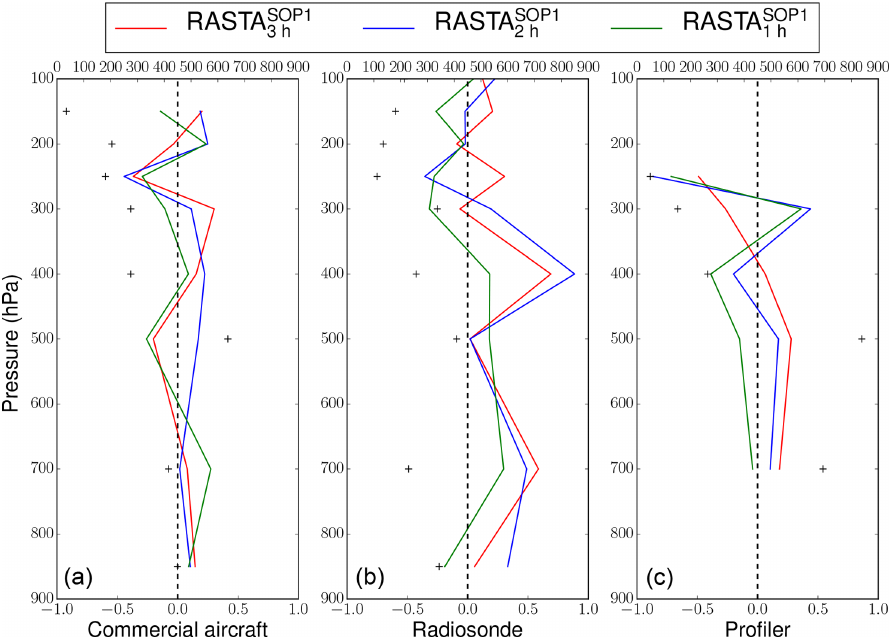
Figure 9. Differences of standard deviation error for 3h wind forecasts between the CTRL COP1 experiment and the RASTA SOP1 RASTA SOP1 (blue) and the RASTA SOP1 (green) experiments. Negative differences indicate a positive impact of the assimilation of RASTA 2h 1h wind data. The standard deviation errors are computed for commercial aircraft (a) , radiosonde (b) and profiler (c) observations. All the scores are computed over the 35 runs in which RASTA wind data were assimilated with the largest assimilation window over the RASTA-limited area. In each panel, the number of observations used for the calculation is represented by the black data plus signs in the top x